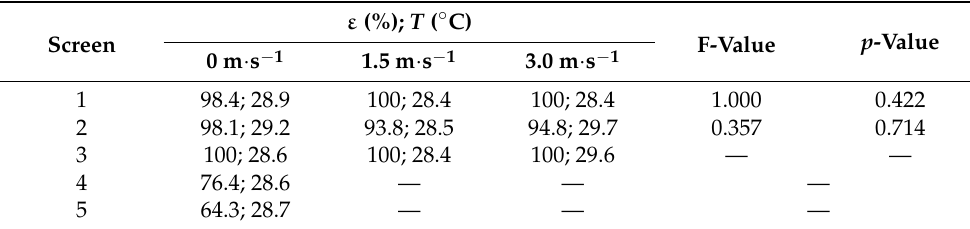
Table 4. Efficacy results of the textiles against D. kuriphilus in the tests carried out at 0, 1.5, and 3.0 m s − 1 and the statistics according to a one-way ANOVA test ( p ≤